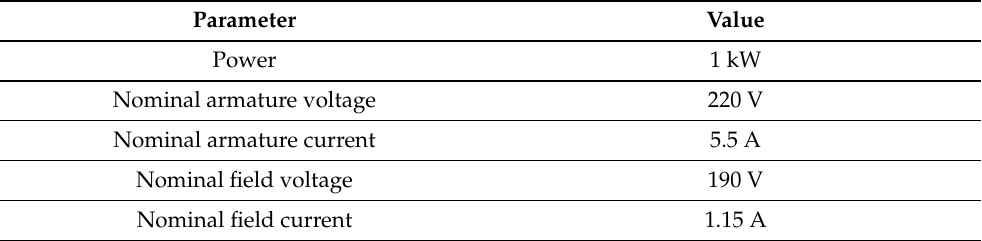
Table 1. Summary of DC motor parameters.